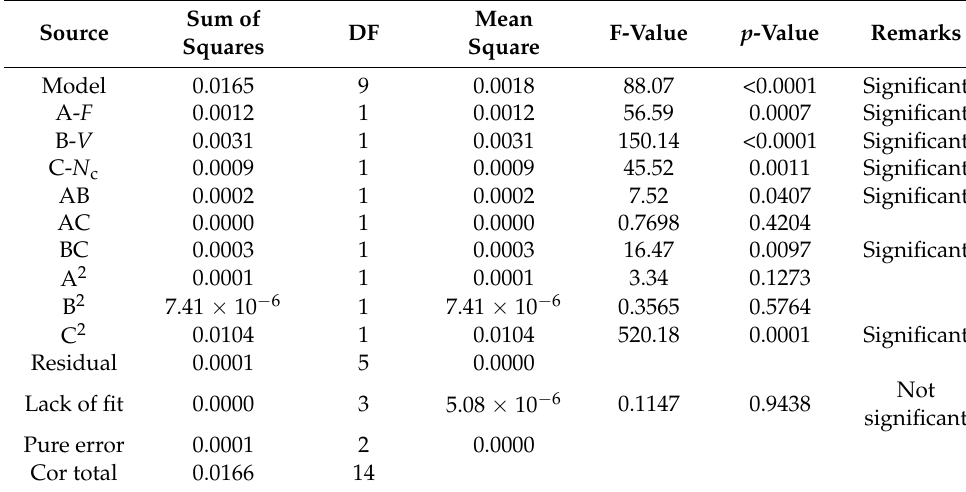
Table 6. ANOVA table of µ value for nanofluids.